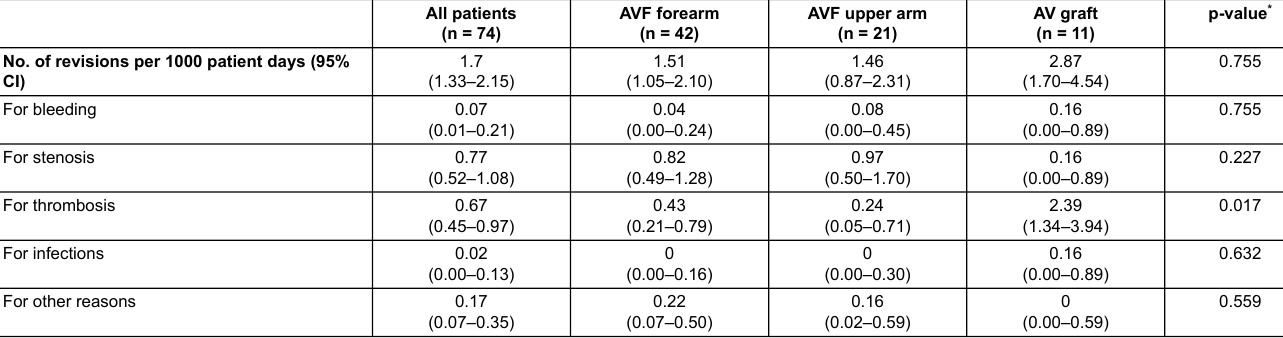
Table 2: Revisions during the follow-up.